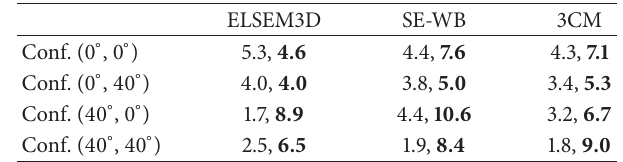
Table 1: Mean power on the interval [0dB − 20dB] (left) and on the interval [ − 20dB − 40dB] (right).